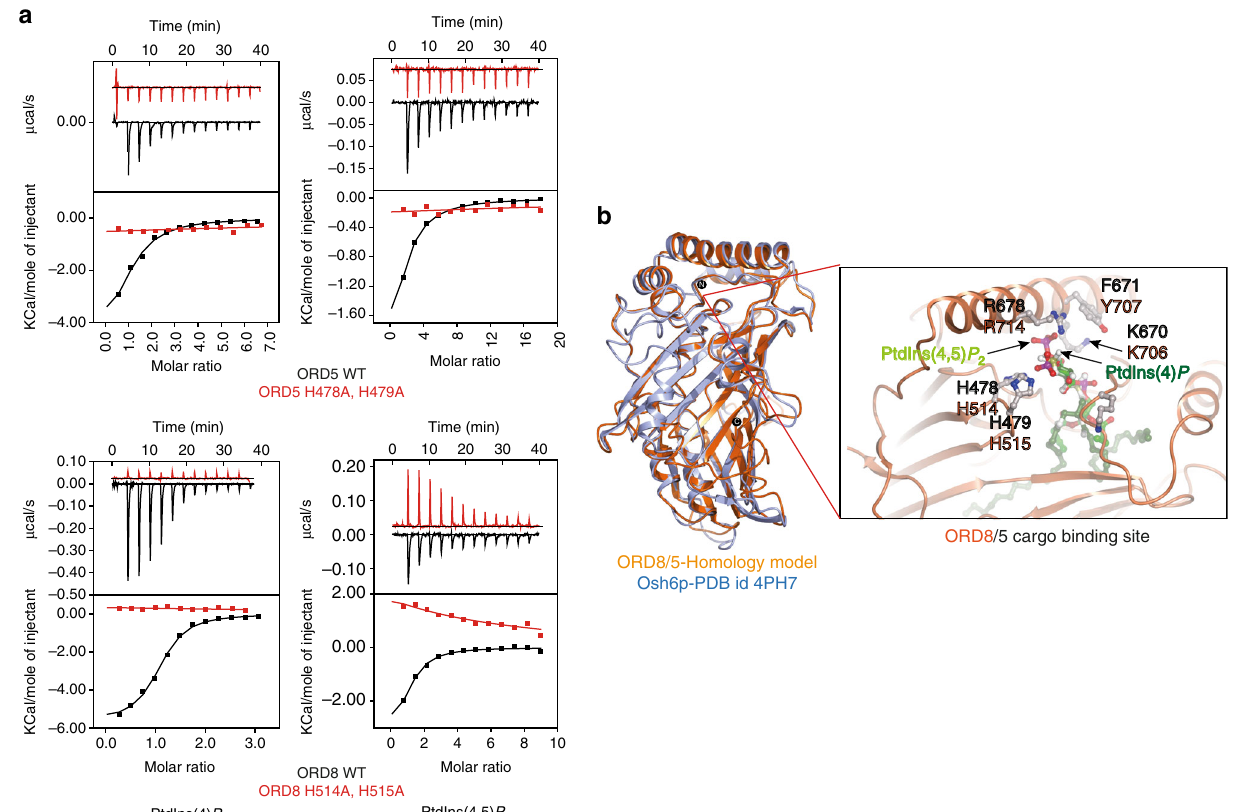
Fig. 4 ORP5 and ORP8 bind PtdIns P species through a conserved binding mechanism. a The binding of puri fi ed ORP5 and ORP8 ORD domain to water- soluble PtdIns P species was measured by ITC. The WT ORD domain of ORP5 and ORP8 binds to all the PtdIns P s (Table 1 and Supplementary Fig. 8), including PtdIns(4) P . No binding was observed with ORD5 (H478A, H479A) and ORD8 (H514A, H515A) suggesting a conserved cargo-binding mode. Experiments were performed at 25 °C using 25 µ M protein in the cell and 500 µ M PtdIns P s injected from the syringe. Top panels show raw data, and bottom panels show integrated normalized data. b The homology model of human ORD8 and ORD5 ( orange ) is superimposed on the Osh6p ( blue , PDB id: 4Ph7, 4B2Z) 14, 16 demonstrating their similar overall architectures. The blow up cartoon representation of the putative cargo-binding site in the ORP8/5 ORD is constructed by superposition of the Osh6p – PtdIns(4) P complex on the ORD8 homology model. The amino acids that mediate cargo binding in the Osh6p structure are conserved in both ORD8 ( orange ) and ORD5 ( black